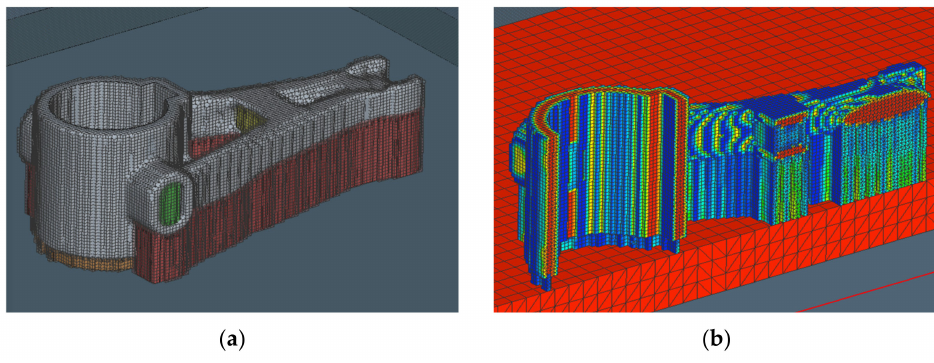
Figure 10. Voxel and surface mesh ( a ) and voxel mesh analysis ( b